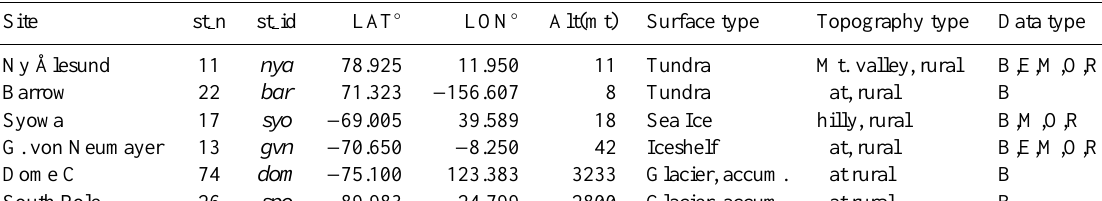
Table 1. List of the BSRN stations covered by the dataset, BSRN station identifier and number and abbreviation (st n / st id), coordinates, surface and topography type. Basic measurements of radiation (B), Expanded measurements (E), Meteorological synoptic observations (M), Ozone measurements (O), and Radiosonde measurements (R).